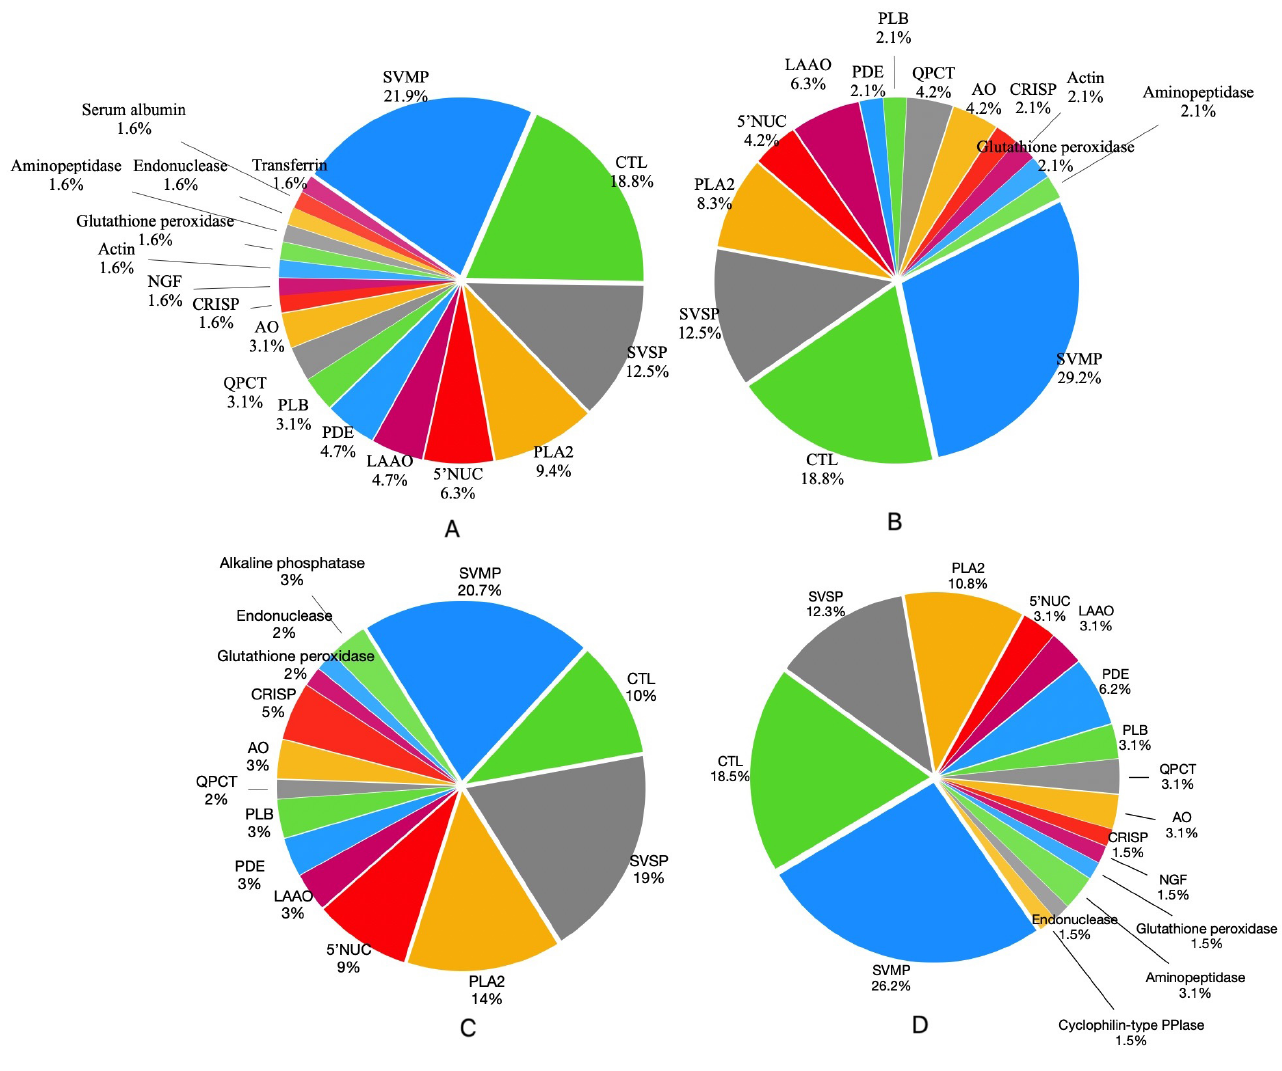
Figure 4. Relative occurrences of venom proteins that were detected from venoms of (A) T. albolabris , (B) T. insularis , (C) T. puniceus , and (D) T. purepureomaculatus . SVMP, snake venom metalloproteinase; SVSP, snake venom serine protease; PLA2, phospholipase A2; CTL, snake C-type lectin; CRiSP, cysteine-rich protein; LAAO, L-amino acid oxidase; PDE, phosphodiesterase; NUC, 5’-nucleotidase; endonuclease, endonuclease domain-containing 1 protein; PLB, phospholipase B; AO, amine oxidase; QPCT, glutaminyl-peptide cyclotransferase; NGF, nerve growth